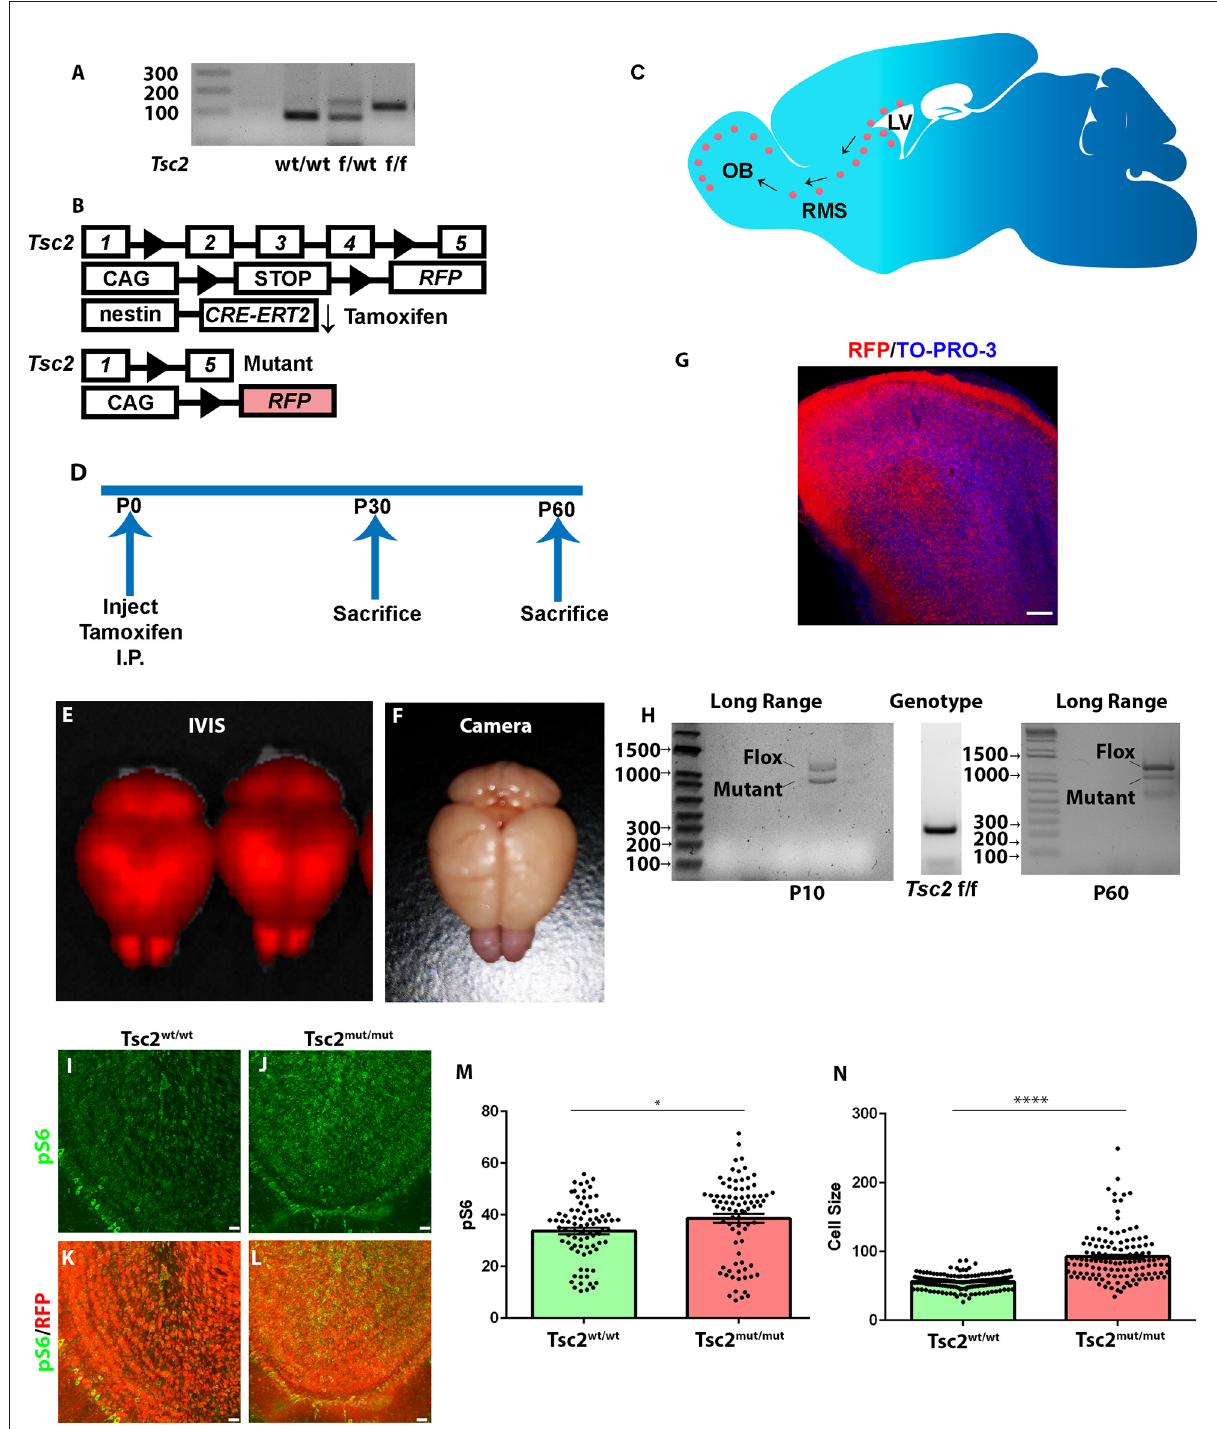
FIGURE1 Modeling loss of Tsc2 in OB granule cells. (A) Genotyping PCR indicating TSC genotypes. (B) Genotypes of mice demonstrating that mouse NSCs express a tamoxifen inducible form of the CRE recombinase. Upon application of this exogenous ligand, CRE recombines regions flanked by loxP sites. This leads to Tsc2 mutation and induction of RFP. (C) Sagittal section of the mouse brain depicting the presence of NSCs around the lateral ventricle that produce neuroblasts that migrate into the RMS and enter the OB. (D) Time course for experimentation. (E) Whole brain fluorescent imaging. (F) Photograph showing pink OBs. (G) Confocal image of sagittal section of a P60 OB. (H) PCR demonstrating that the Tsc2 gene undergoes recombination. (I–L) Confocal image of OBs demonstrating OB pS6 levels. (M) Quantification of OB pS6. (N) Quantification of cell size. ∗ p < 0.05, ∗∗∗∗ p < 0.0001; OB, olfactory bulb; RMS, rostral migratory stream; LV, lateral